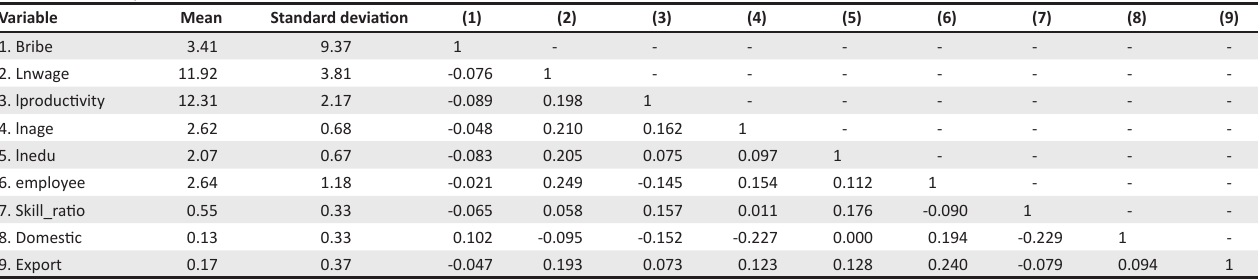
TABLE 2: Summary statistics. Variable